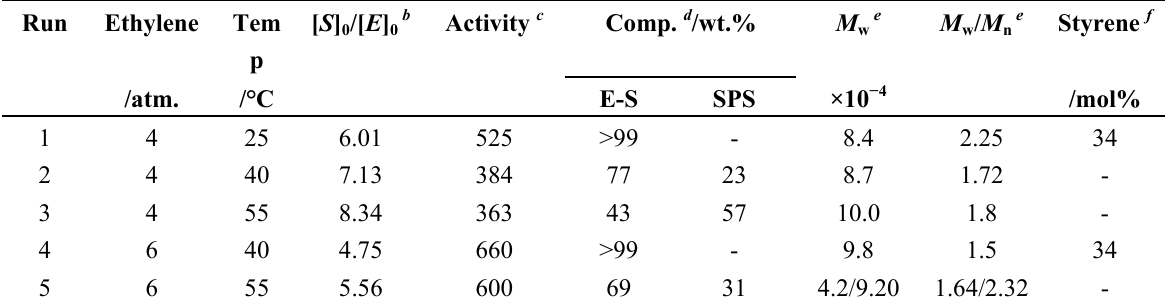
Table 5. Copolymerization of ethylene with styrene by Cp*TiCl ( 4 )–MAO catalyst system [55] a .